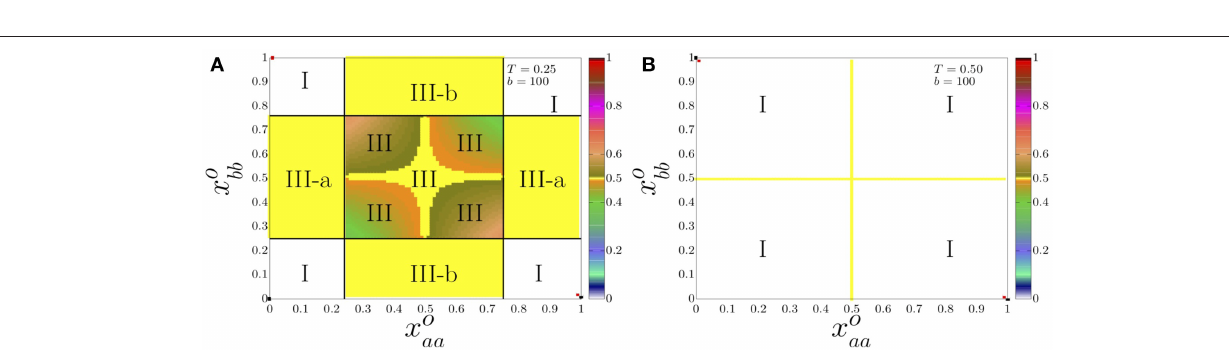
FIGURE 9 | Plot in color scale of the fraction of active links between layer A and B in the asymptotic solution of the dynamics as a function of the initial density of x aa and x bb for the Asymmetric Coordination Game. The color scale defines the values of the fraction of actives links, n AB = 1 black color and n AB = 0 white color. Asymptotic solutions are as indicated. (A): b = 100, T = 0.25, and (B): b = 100, T =